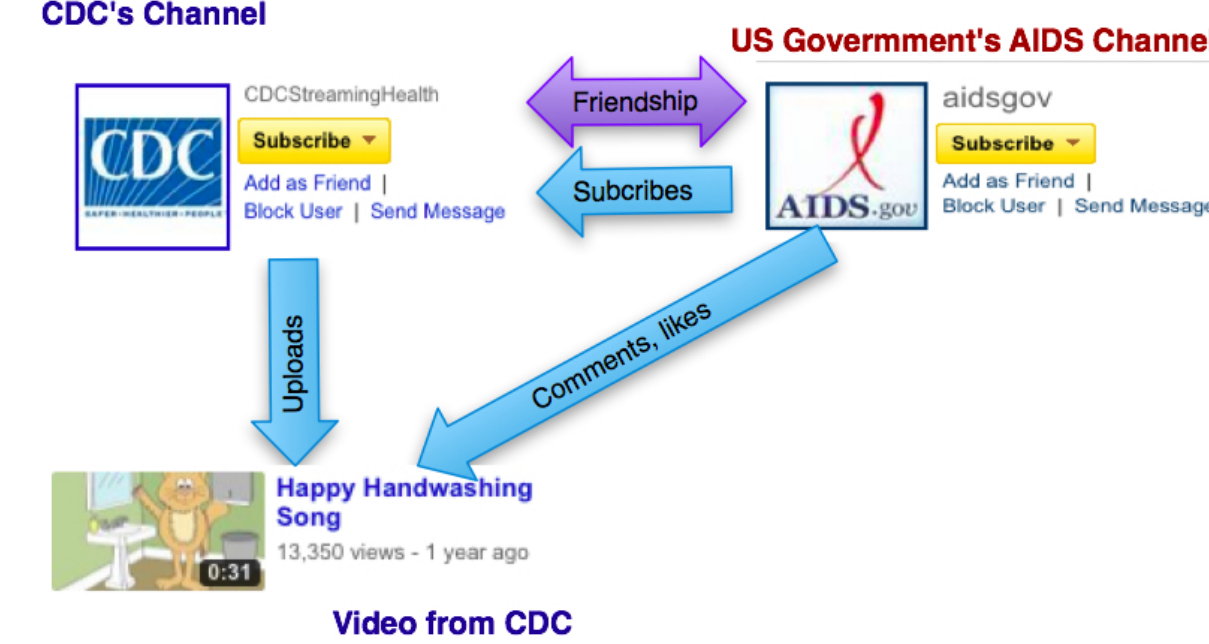
Figure 3. YouTube’s social network. CDC = Centers for Disease Control and